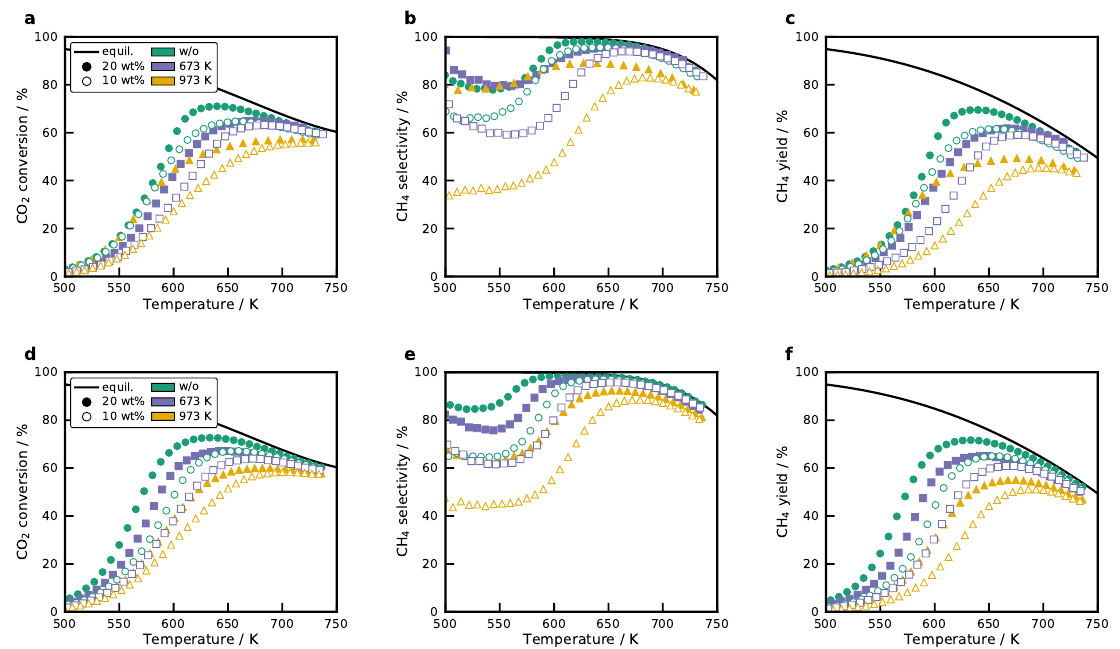
Figure 10. CO 2 conversion, CH 4 selectivity, and CH 4 yield for BB(20) ( a – c ) and BB(8) ( d – f ). Solid lines represent the equilibrium. All figures share the same legend. Conditions: m cat = 30mg, β = 20Kmin − 1 , WHSV = 100L N h − 1 g − 1